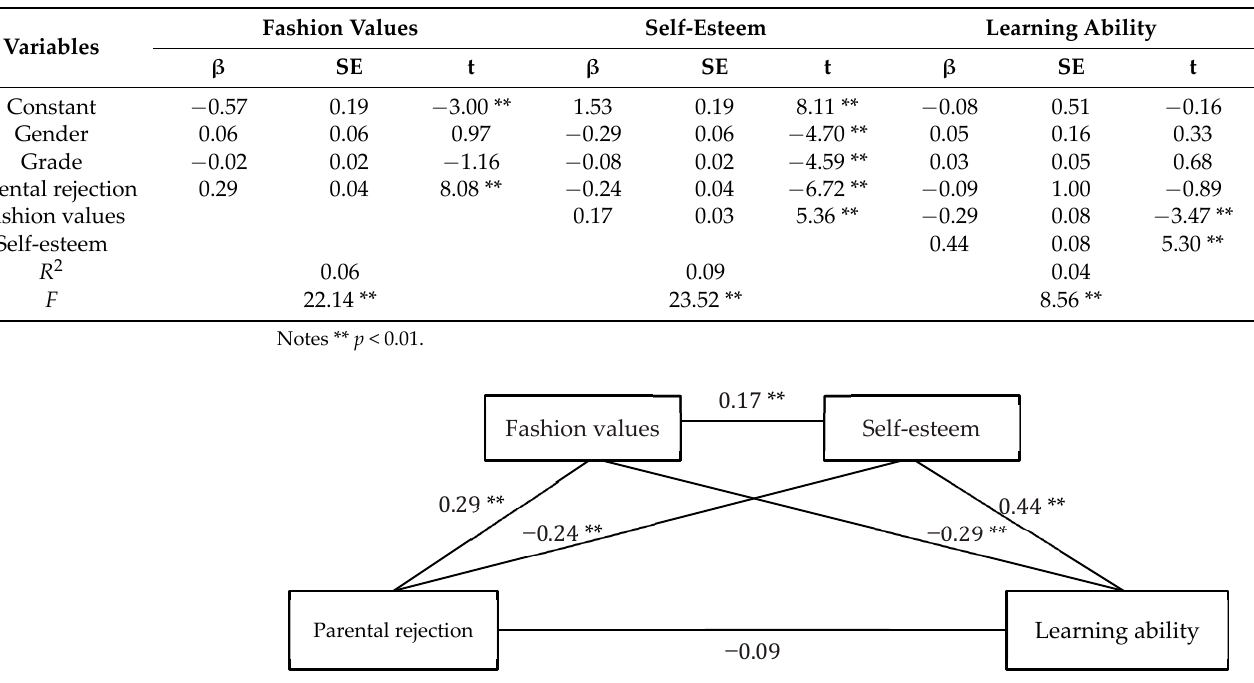
Table 2. Multiple mediating model between parental rejection and learning ability ( N = 997).